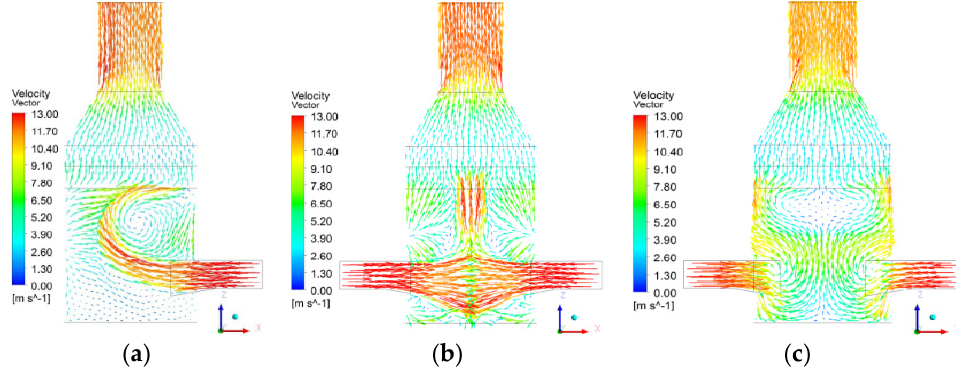
Figure 5. The gas velocity vector diagram without spray; ( a ) Single inlet; ( b ) Straight dual inlet; ( c ) Tangential dual inlet.